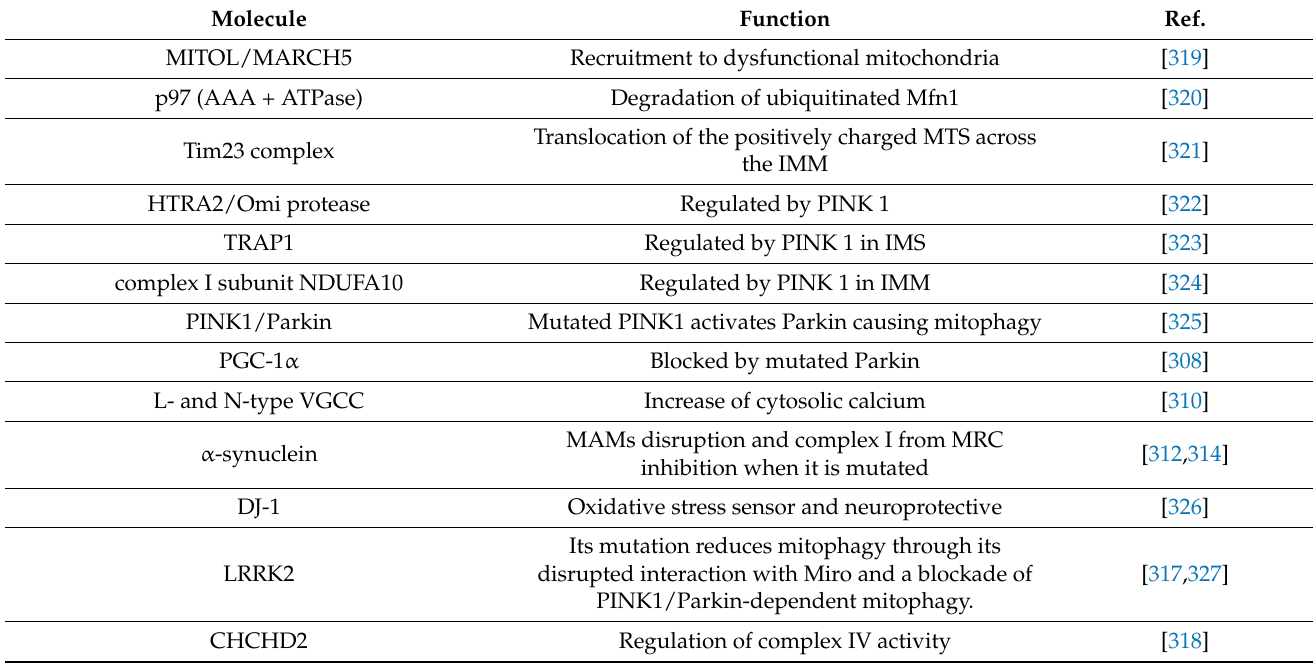
Table 5. Proteins involved in mitochondrial dysfunction in Parkinson